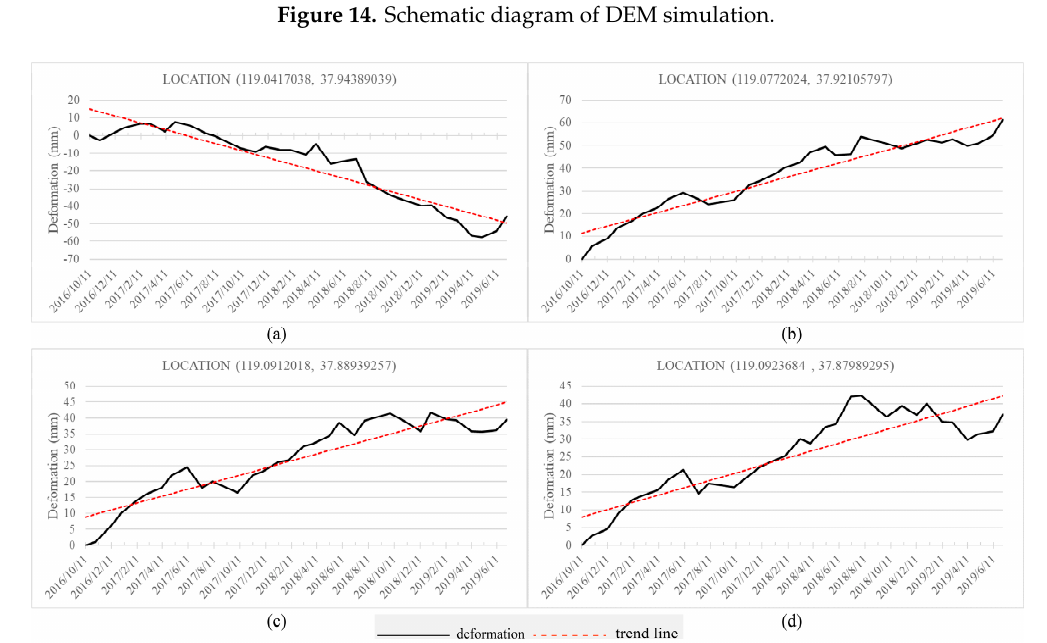
Figure 15. Regular analysis of deformation rate. The position of the four points is the triangle position shown in Figure 9 ( a ), ( b ), ( c ) and ( d ).